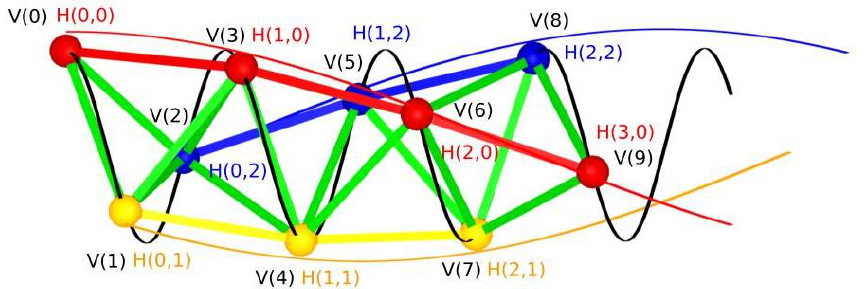
Figure 11. Node (Coxeter) helix (in black) and rail helices (in red, blue, and yellow), different than joint